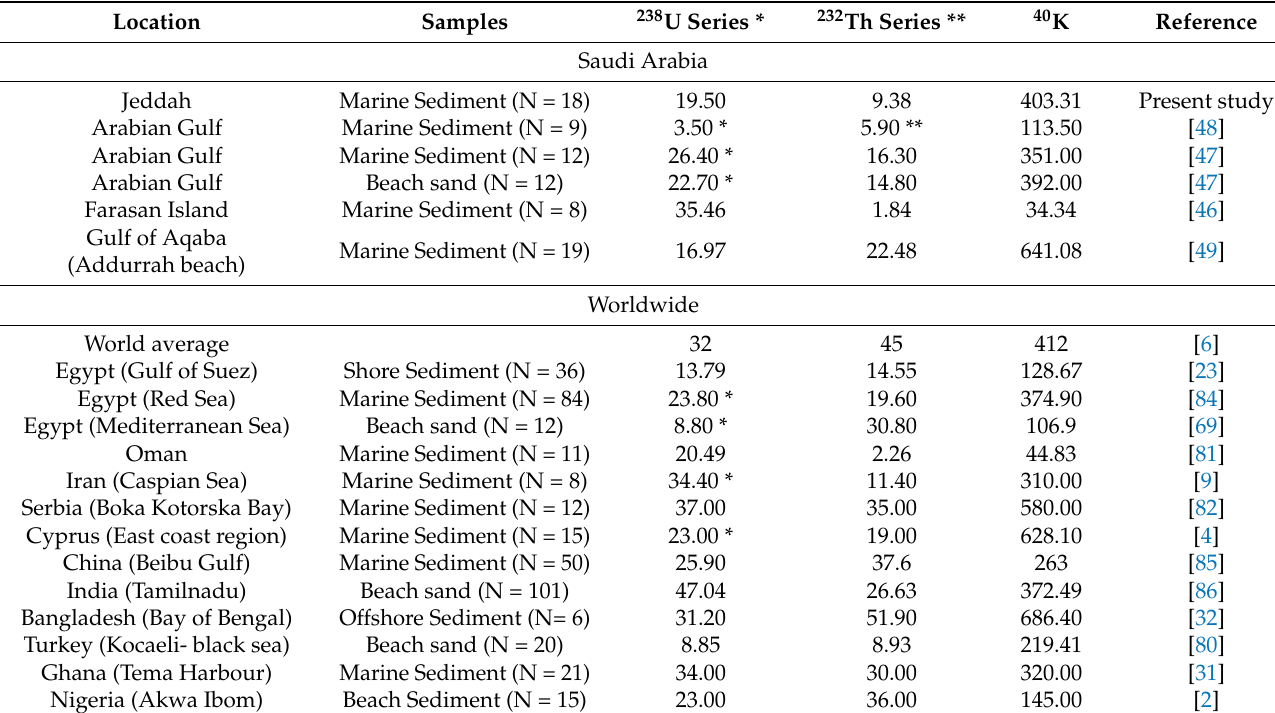
Table 2. Comparison of 238 U, 232 Th, and 40 K mean activity concentration in marine sediment and sand samples reported for different region in Saudi Arabia and